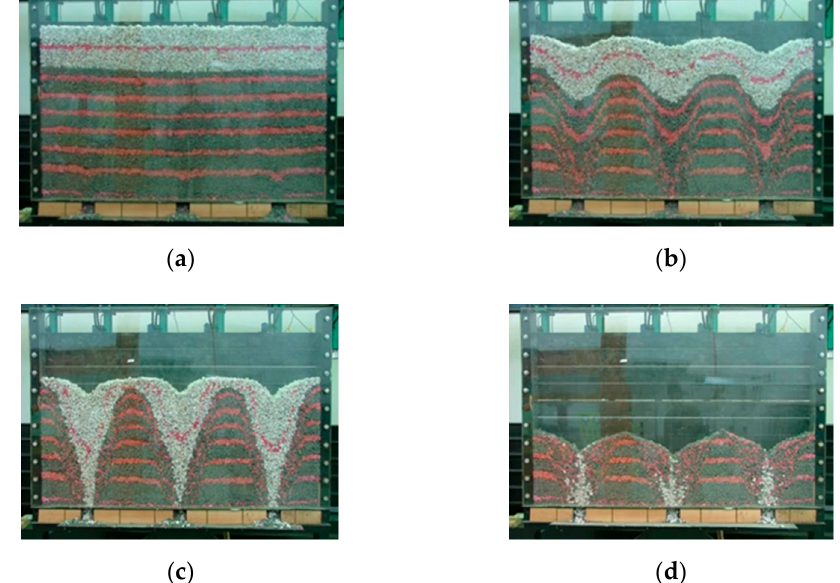
Figure 15. Drawing process diagram ( a ) before drawing, ( b ) at the initial drawing stage, ( c ) at the middle drawing stage, and ( d ) at the end of ore drawing.